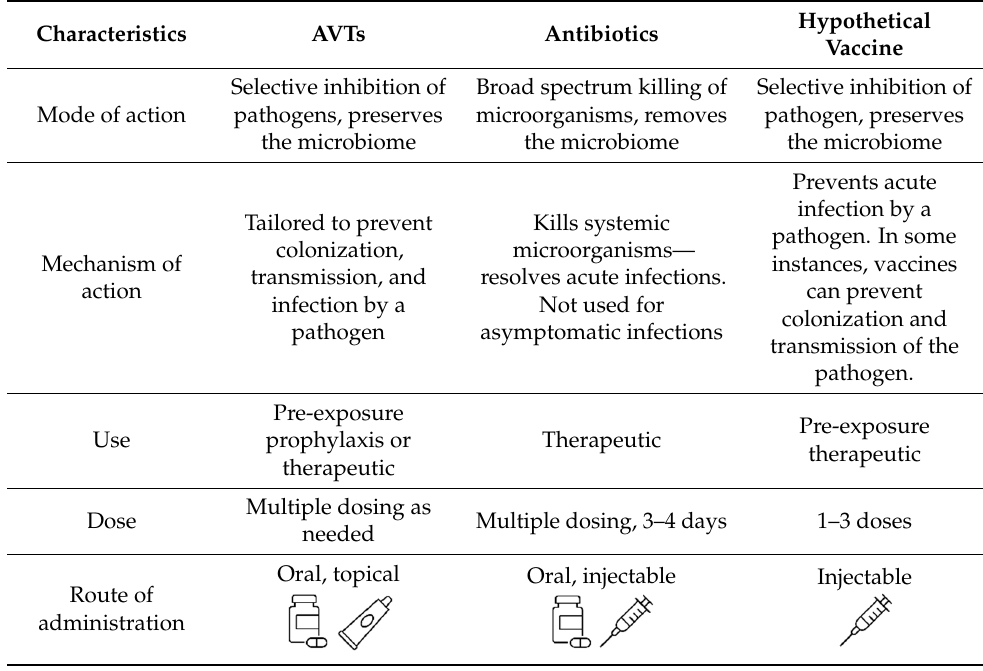
Table 2. Characteristics of AVTs, antibiotics and vaccines *.